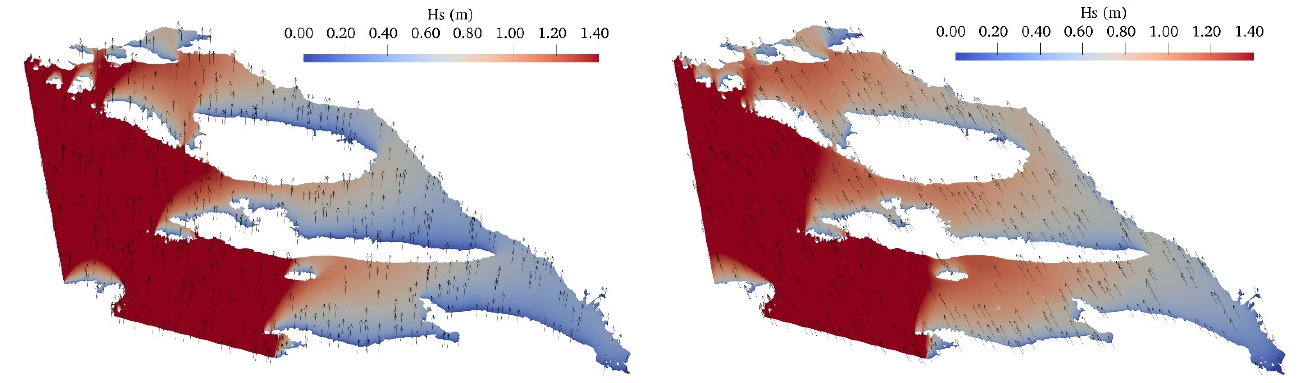
Figure 15. Snapshot of spatial variation of significant wave height across the domain on the ( left ) 30 October 2008, at 9:00 when the simulated wind direction is SSW; ( right ) 1 November 2008, at 5:00 when the simulated wind direction is SE.